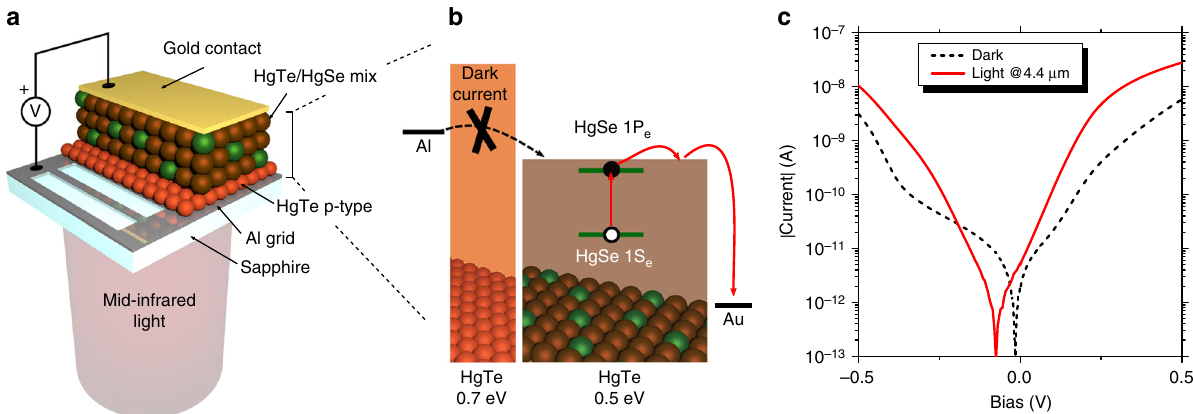
Fig. 4 Design of an intraband photodiode from a colloidal quantum dot infrared photodetector. a Scheme of the device. Illumination is provided from the back side through a sapphire substrate and a patterned aluminum electrode allowing 70% of light transmission in the mid-infrared. b Band alignment diagram of the diode structure. HgTe 6k is used as a unipolar barrier to fi lter injection of dark current into the active HgSe/HgTe 4k layer. c . I ( V ) characteristics of the device measured at 80 K in the dark and in front of a 4.4- µ m quantum